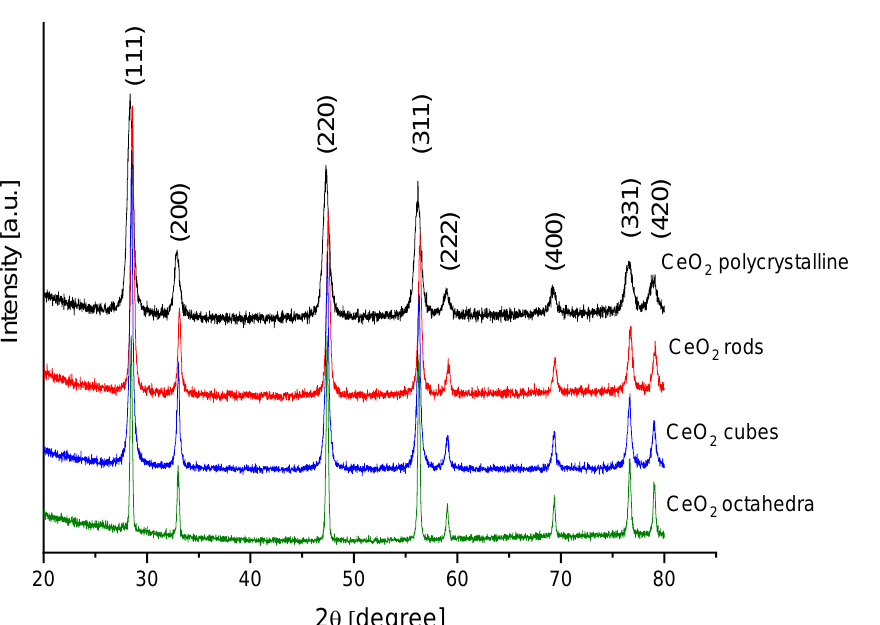
Figure 5. XRD profiles of different cerium dioxide shapes. Table 2. Calculated values of particle size and band gap of cerium dioxide shapes.